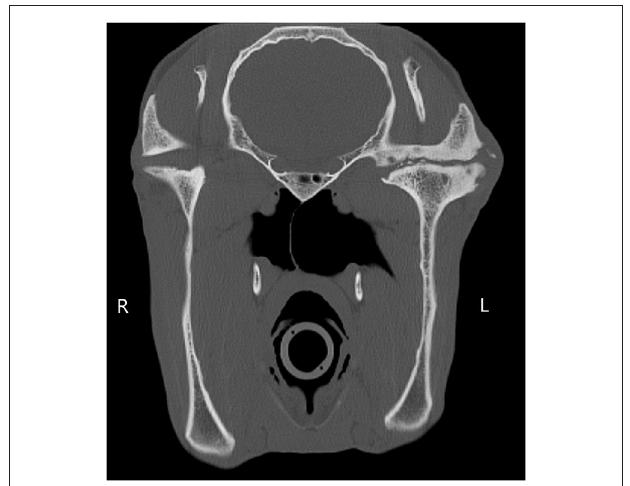
FIGURE 1 | A transverse CT image showing soft tissue swelling, an irregular narrowed joint margin of the left mandibular condyle, multiple intra-articular osseous fragments, sclerosis and subchondral lucencies of the mandibular condyle and temporal bone. There is evidence of unilateral joint collapse, characterized by the reduced height of the vertical ramus of the left mandible compared to the right.